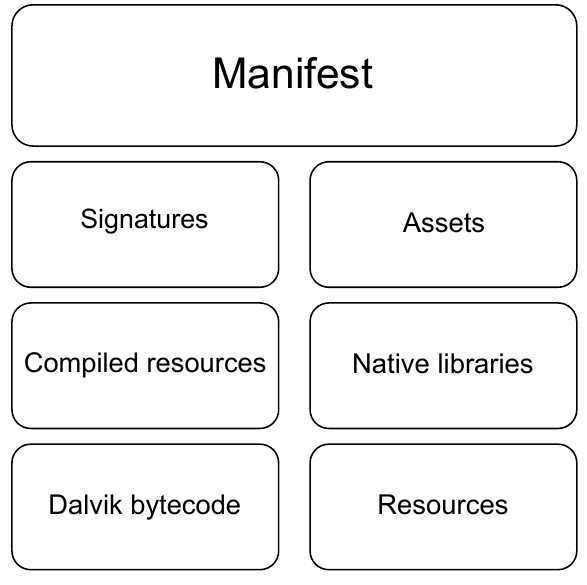
Figure 1. The main structure of an APK file